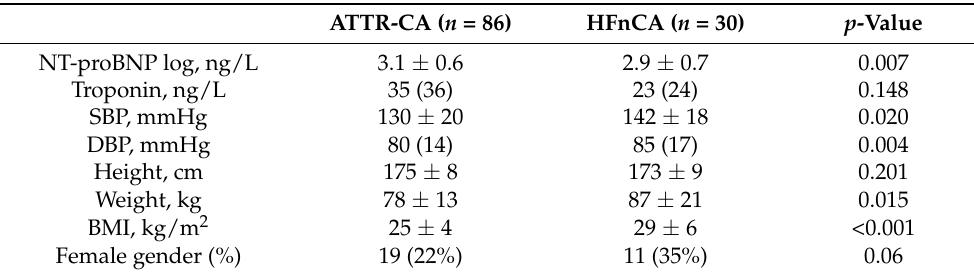
Table 1. Clinical data at the time for DPD verified